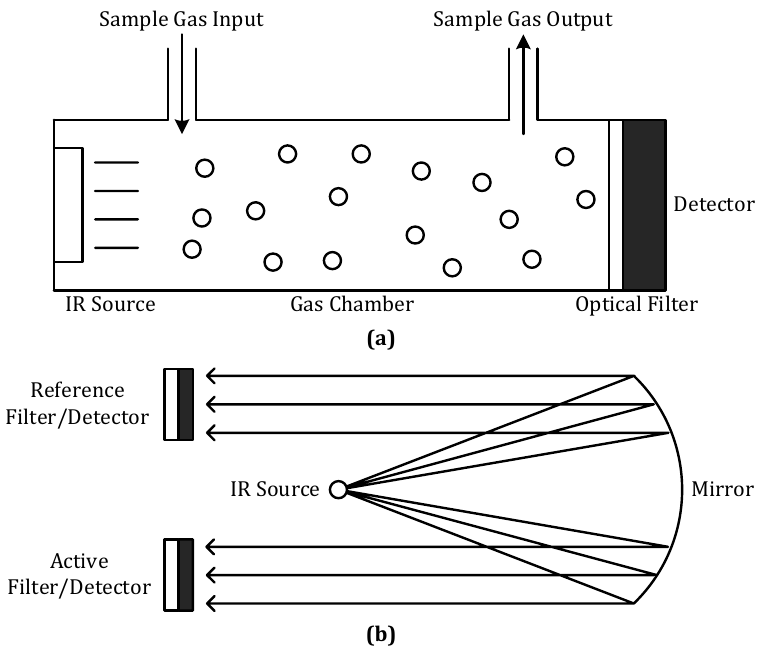
Figure 4. IR-source gas sensors ( a ) based on the basic absorption spectrometry and ( b ) with reference